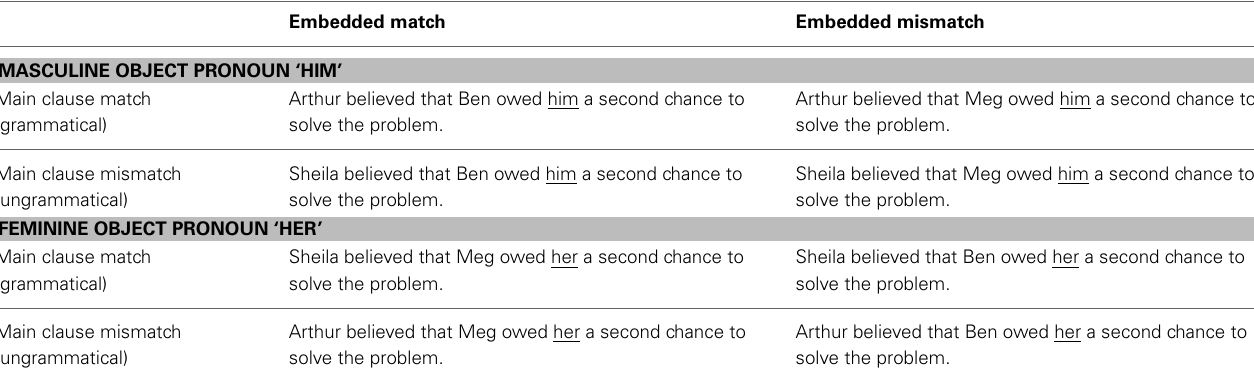
Table 3 | Experimental conditions and sample materials in Experiment